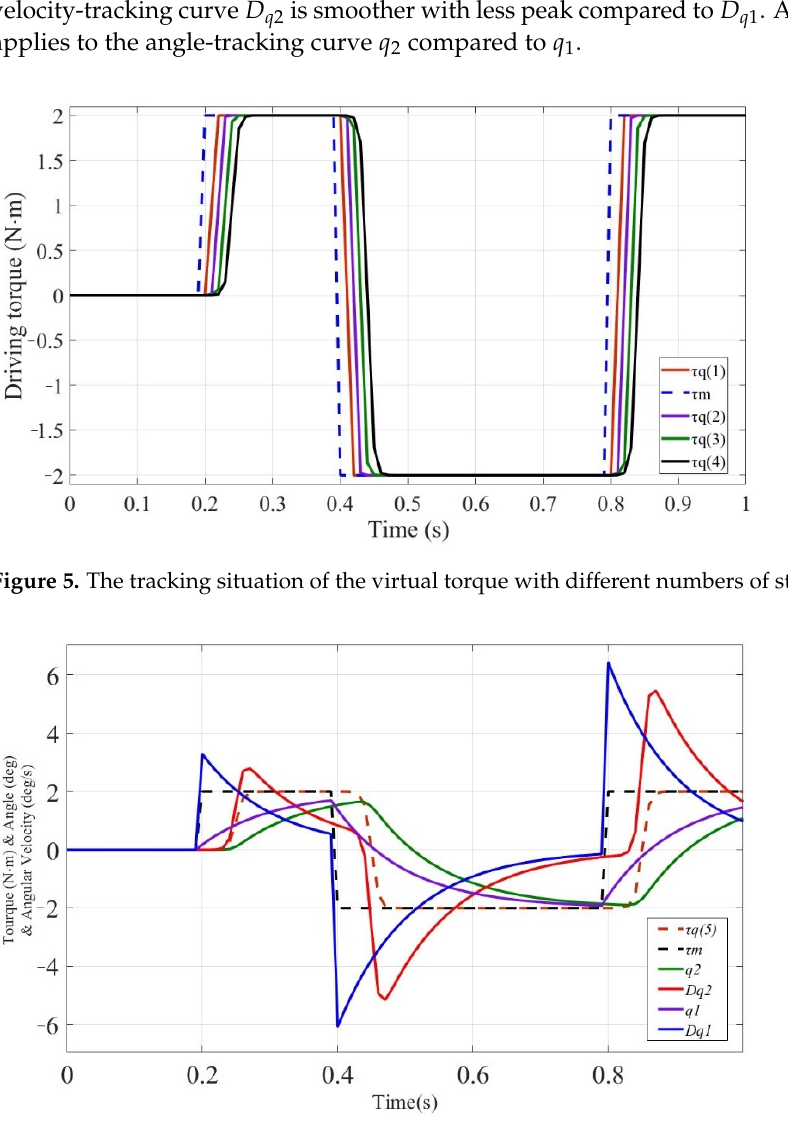
Figure 7. Prototype device of the upper-limb exoskeleton manipulator. Table 2. Exoskeleton joint range of motion. Joint